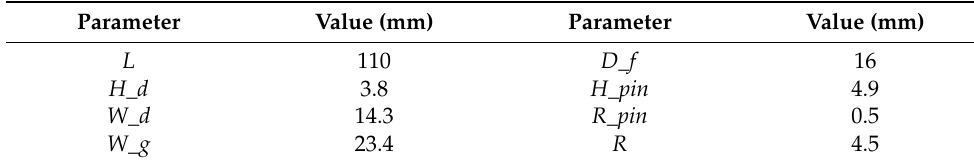
Table 1. Detailed dimension of the designed element antenna.